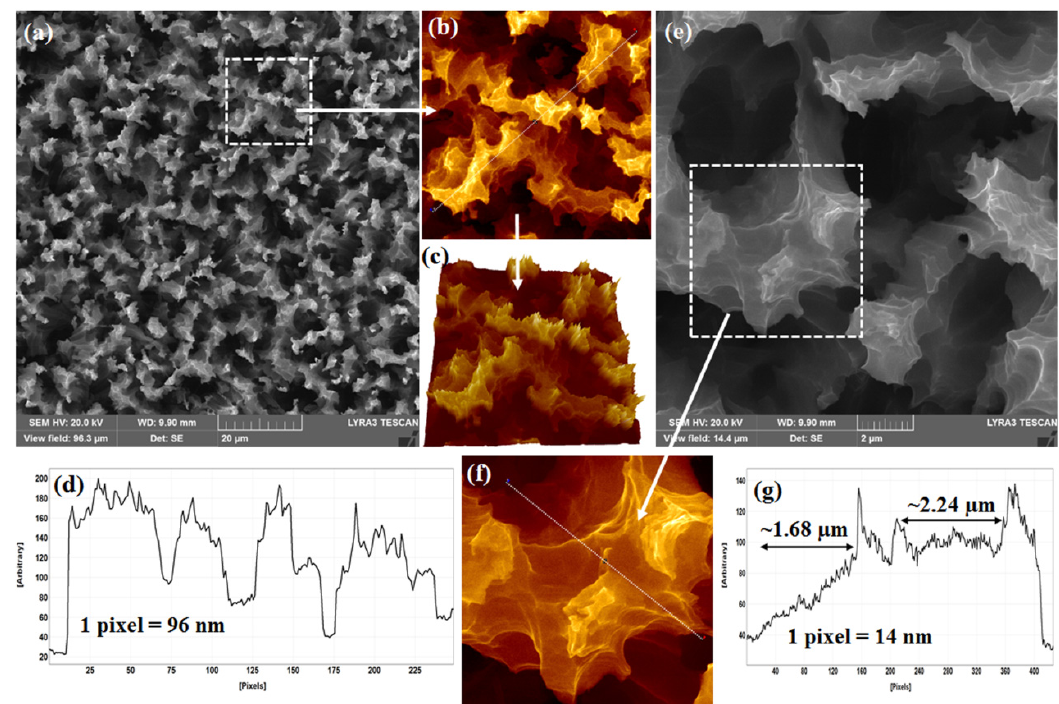
Figure 1. ( a ) FESEM micrograph of as-fabricated Si-NSs, ( b ) Zoom-in view of a small area (20 µm × 20 µm) as marked by the white dotted square in Figure 1a, ( c ) Hawk-eye view (3D) of the same confirming terraces of various sizes available in Si-NSs, ( d ) Line profile along the white dotted line crossing as-fabricated Si-NSs as shown in Figure 1b confirming the hills and valleys that contain different dimensions of terraces, ( e ) High-resolution FESEM micrograph of as-fabricated Si-NSs, ( f ) Zoom-in view of a small area (5 µm × 5 µm) as marked by the white dotted square in ( e ), and ( g ) Line profile along the white dotted line crossing as-fabricated Si-NSs as shown in ( f ) confirming the variation in sizes and shapes of terraces.